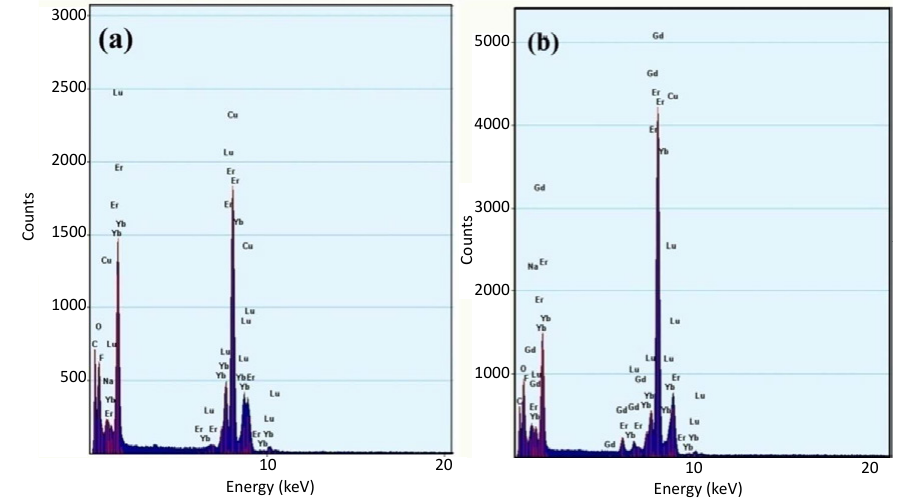
Fig. 4 EDS spectra for (a) 20%Yb 3+ /2%Er 3+ :NaLuF 4 (b) Yb 3+ /Er 3+ /Gd 3+ doped NaLuF